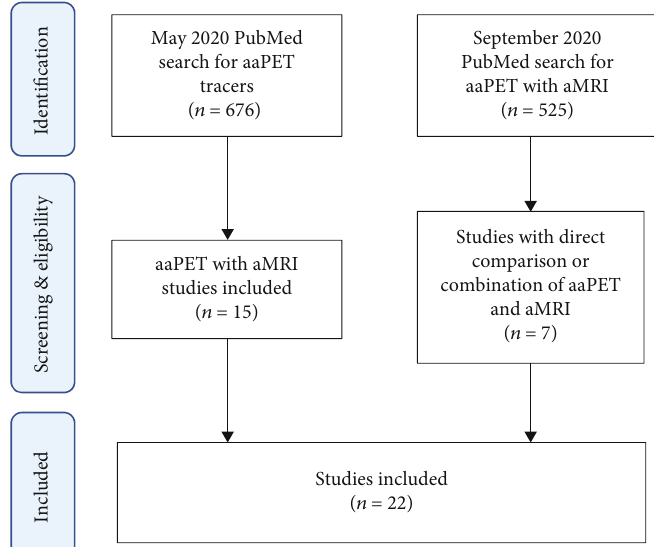
Figure 1: PRISMA study selection fl